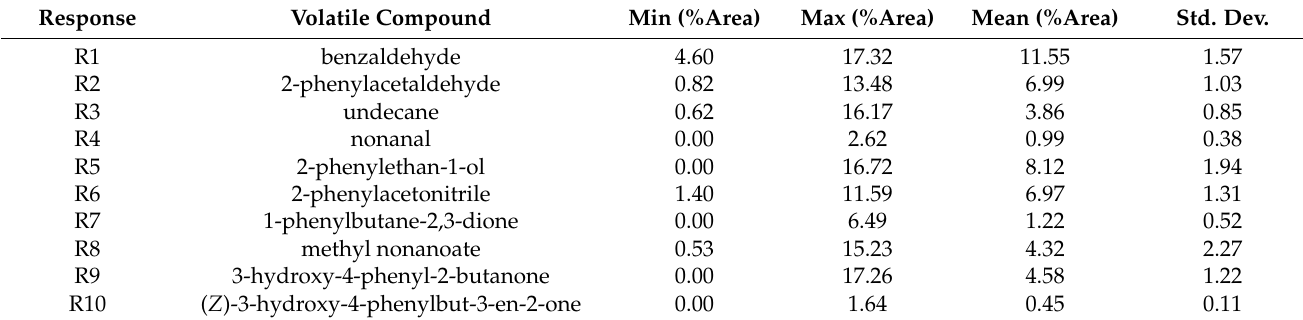
Table 3. Responses (volatile compounds) used for the optimization model.